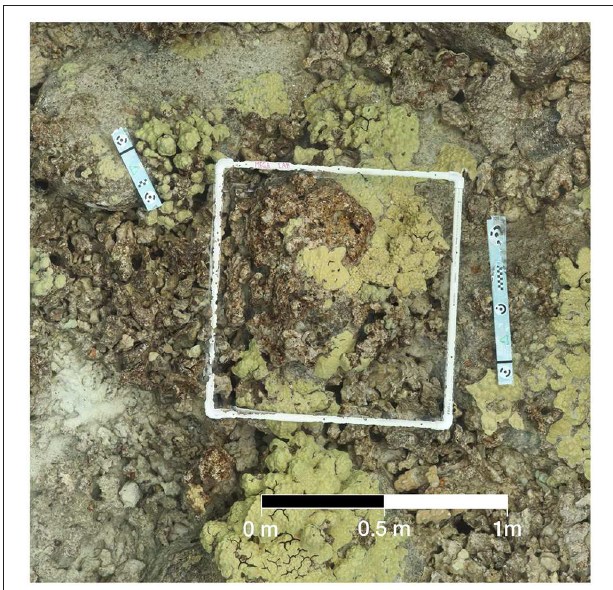
FIGURE 1 | Example of orthomosaic used in digital health surveys. When zoomed in, details of this image can be resolved at a high resolution with raster cells under 1 cm in